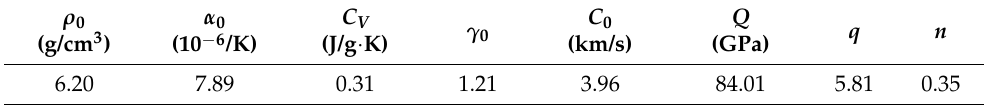
Table 1. The calculation parameters for Zr 68.5 Cu 12 Ni 12 Al 7.5 amorphous